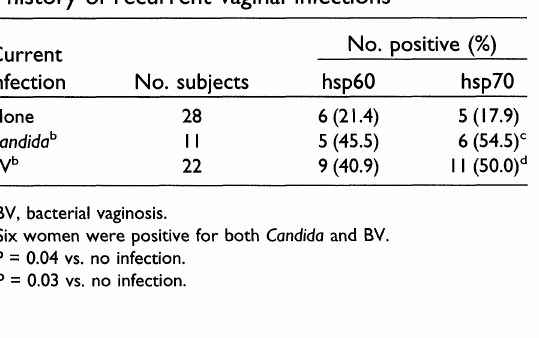
TABLE 2. Hsp60 and hsp70 in sera of women with a history of recurrent vaginal